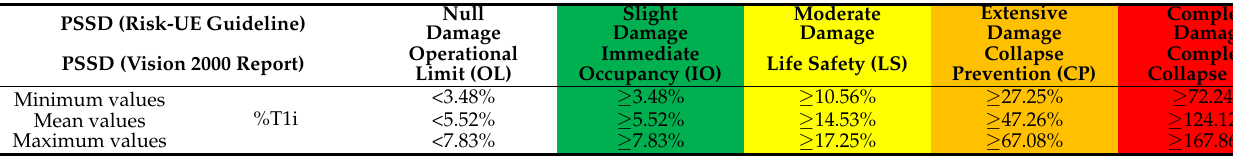
Table 9. Preventive “Semaphore” for Seismic Damage (PSSD) based on the average %T 1i (DS non-null ) probabilistic of the four buildings studied.